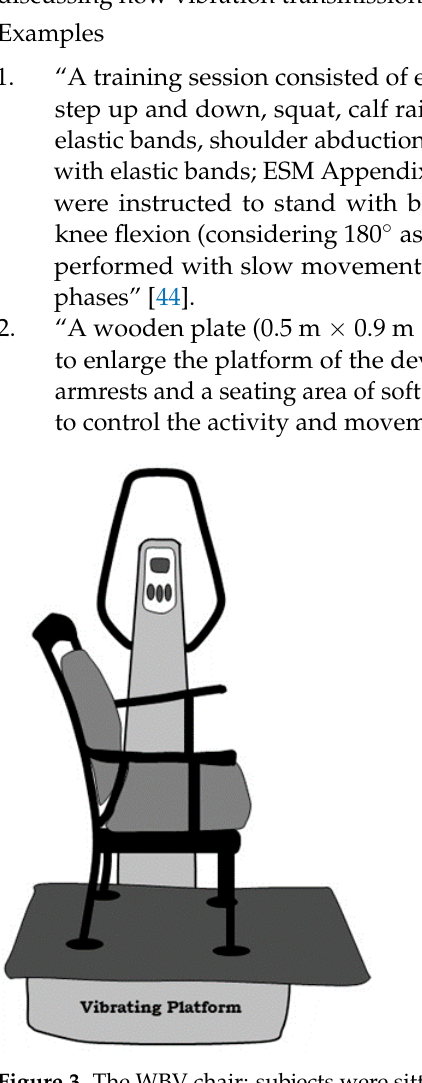
Figure 3. The WBV chair: subjects were sitting on the chair with their feet on the wooden plate and their hands on the arm rests (adopted from Regterschot et al.